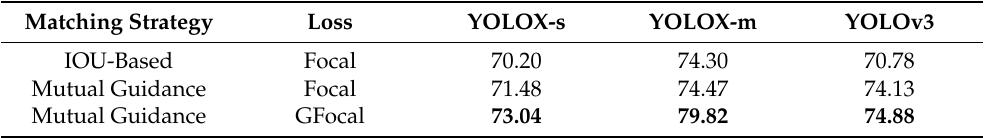
Table 1. Mutual guidance for different backbone architectures on VEDAI25 dataset. The best performance per column is shown in boldface.